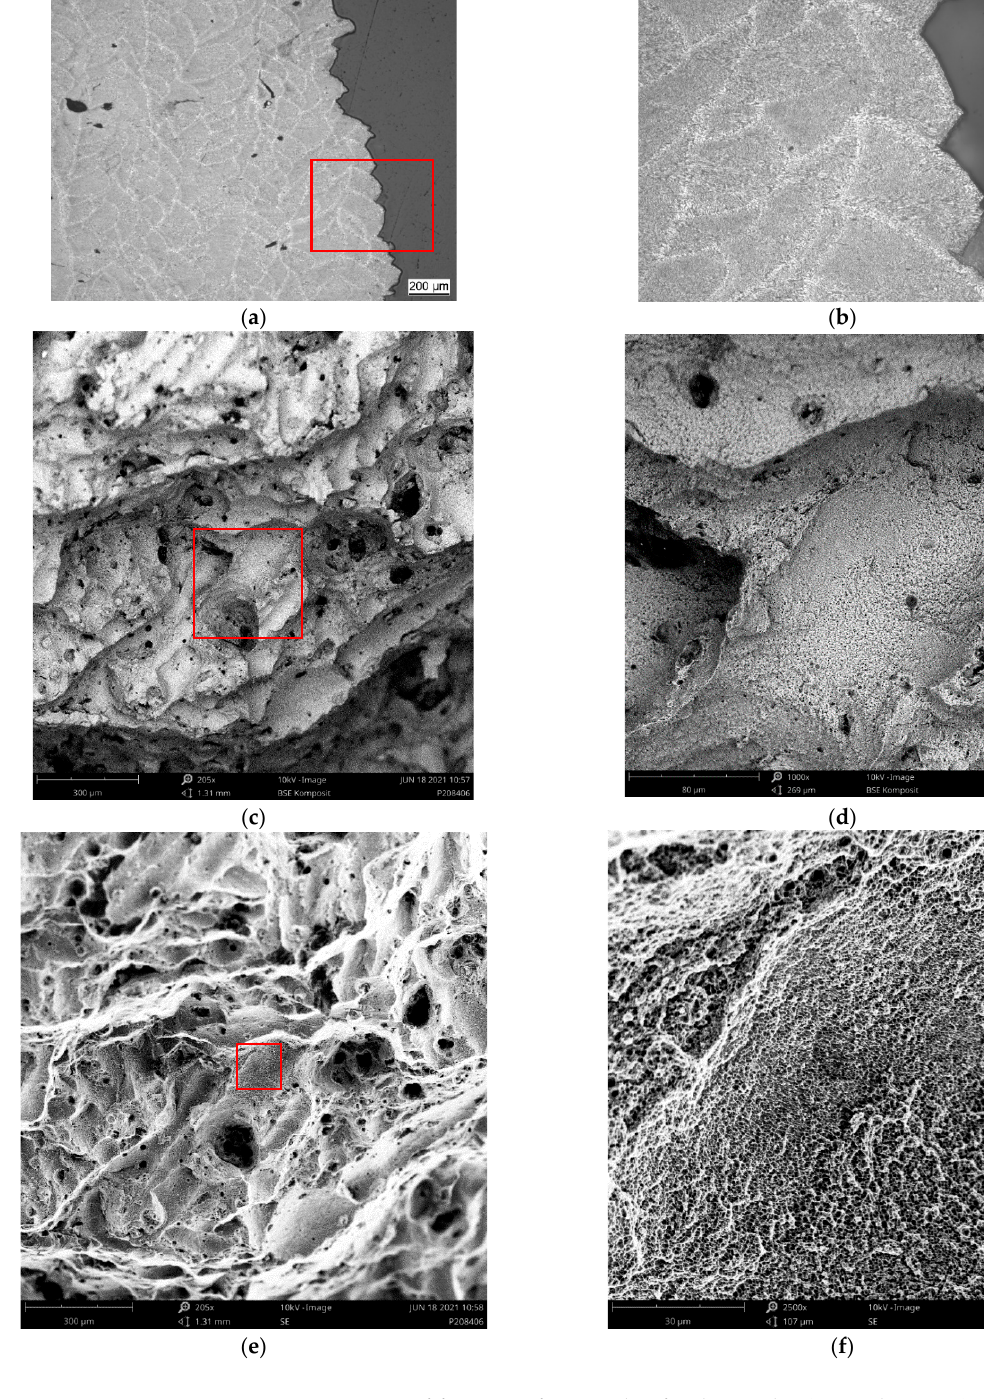
Figure 10. Region of fracture of a sample of polar angle 0° tested at 250 °C: ( a , b ) metallographic section of etched samples at different magnifications, ( c , d ) back-scattered electron (BSE) images of the fracture surface at different magnifications and ( e , f ) secondary electron (SE) images of the frac- ture surface, overview and detailed view. Note that the red box in the image on the left highlights the area depicted in the magnified view on the right.